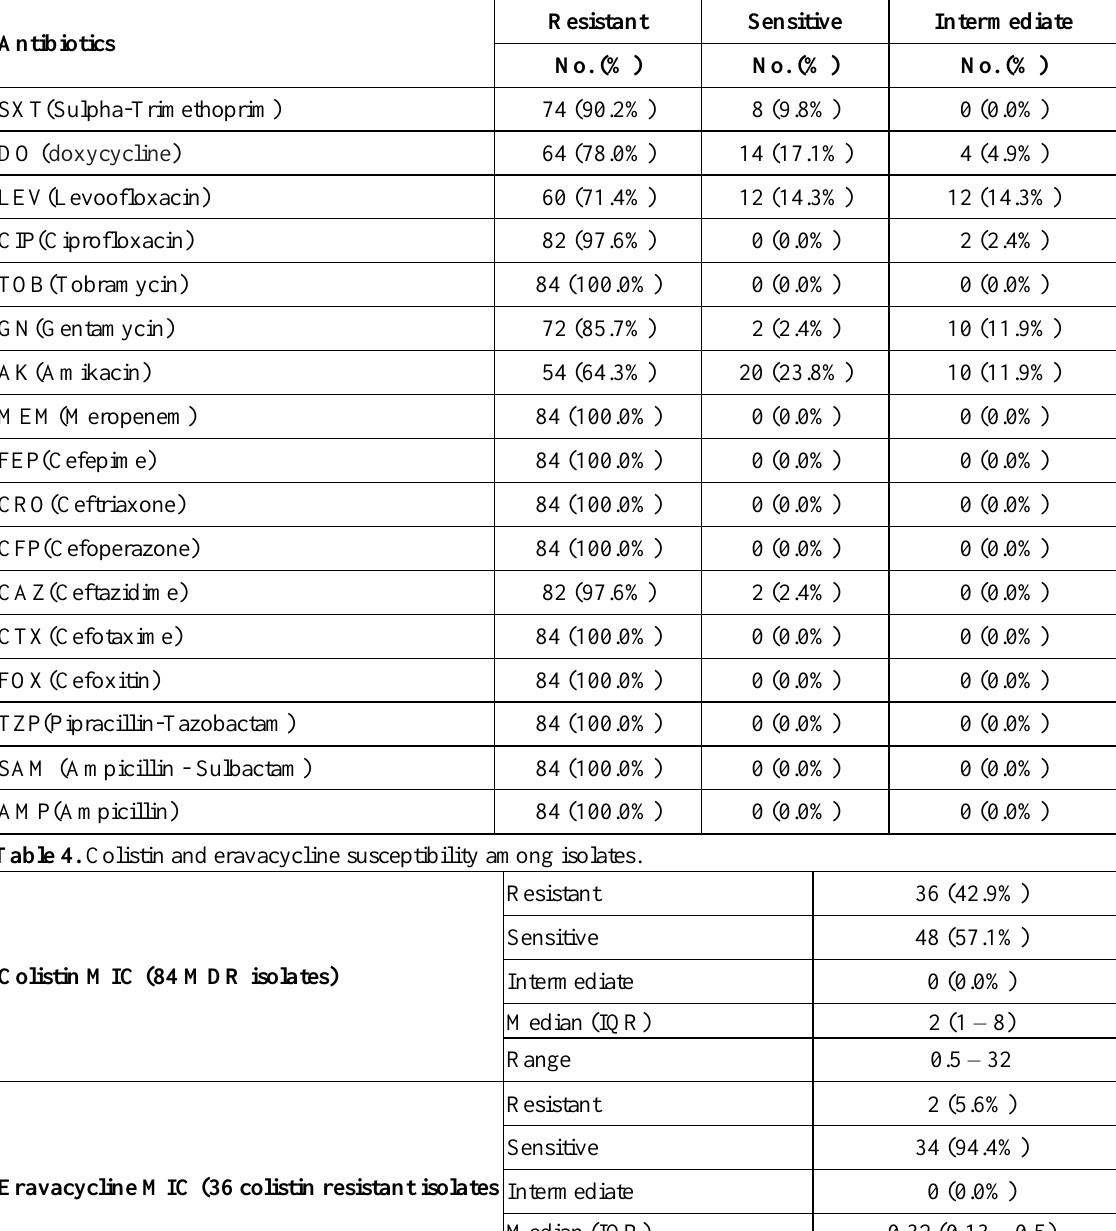
Table 3. Antimicrobial susceptibility among isolates.